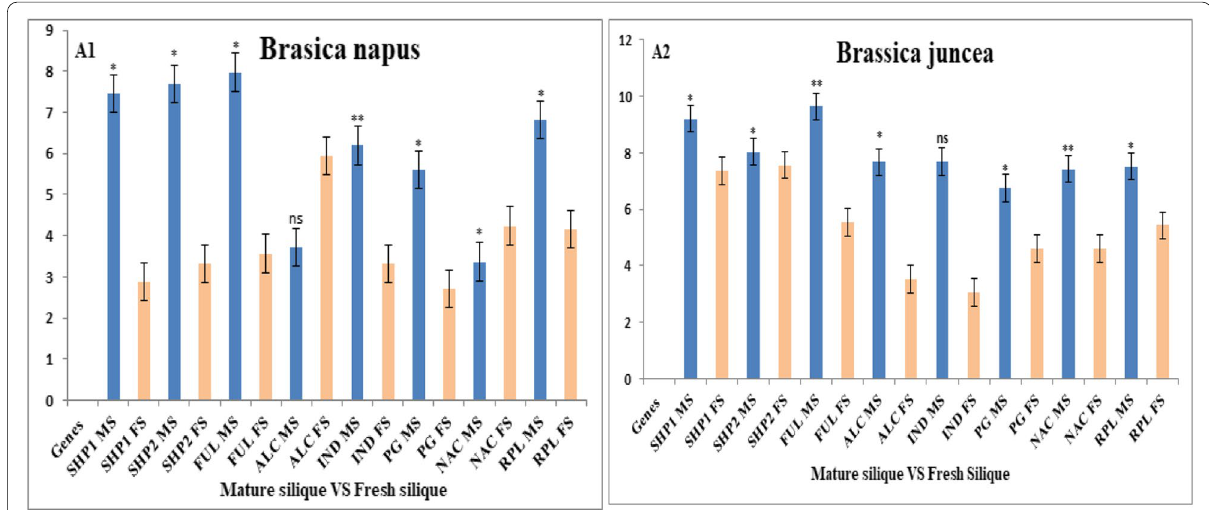
Fig. 6 The expression levels of shattering genes in B. napus and B. juncea : Graph bar defining the difference and the correlation in the expression level among two tissues of B. napus and B. juncea . A1 A lower level of shattering genes expression in B. napus than B. juncea . A2 A higher level of shattering genes expression in B. juncea than B. napus in the given tissues. ALC gene expressed more in B. napus fresh silique. Lower expression of ALC gene was observed in fresh silique of B. juncea but highly expression was observed in mature